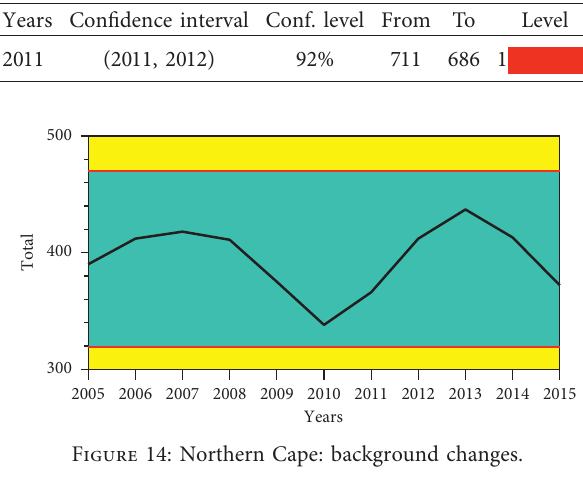
Table 9: Table of significant changes for murder in Mpumalanga. Years Confidence interval Conf. level From To